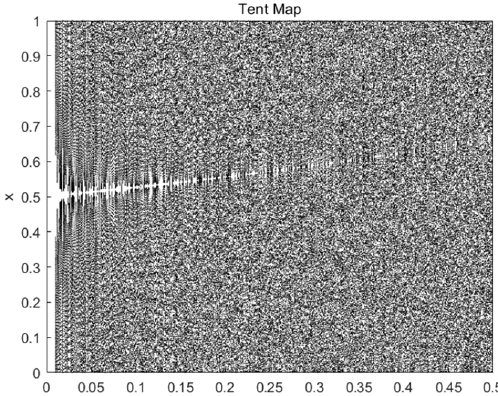
Figure 3. Tent chaotic map distribution. Table 1. Main steps of tent chaotic map.